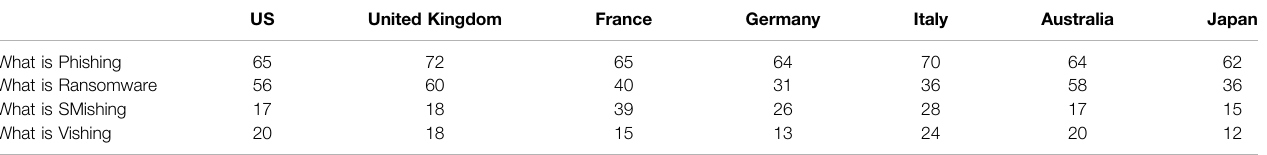
TABLE 1 | Percentage of respondents understanding multiple cybersecurity terms from different